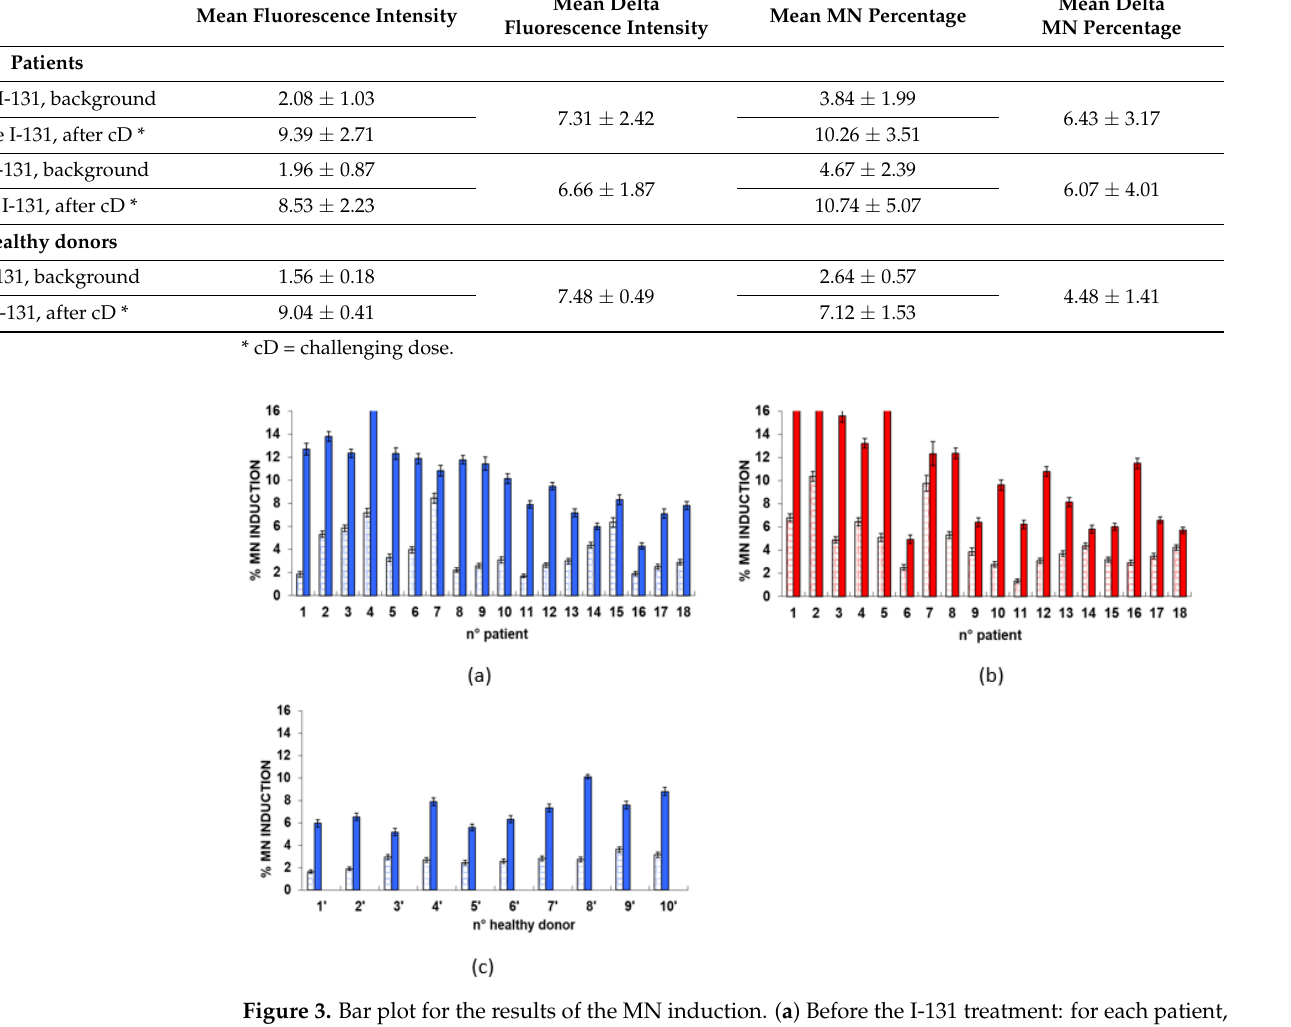
Figure 3. Bar plot for the results of the MN induction. ( a ) Before the I-131 treatment: for each patient, two bars are grouped corresponding to results obtained before and after the cD (1 Gy), respectively. ( b ) After the I-131 treatment: for each patient, two bars are grouped corresponding to results obtained before and after the cD (1 Gy), respectively. ( c ) Healthy donor: the two bars correspond to the results before and after the cD (1 Gy), respectively. The error bars represent the propagation of the error.